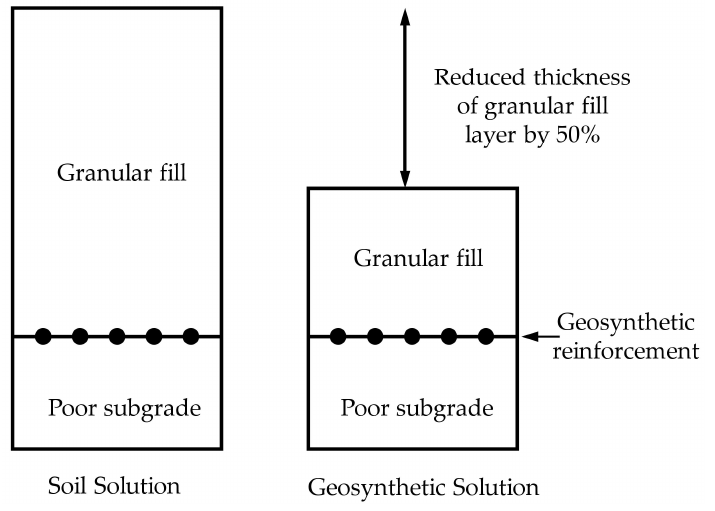
Figure 1. Scheme of road profiles without/with reinforcement of geosynthetics, adapted from [42].